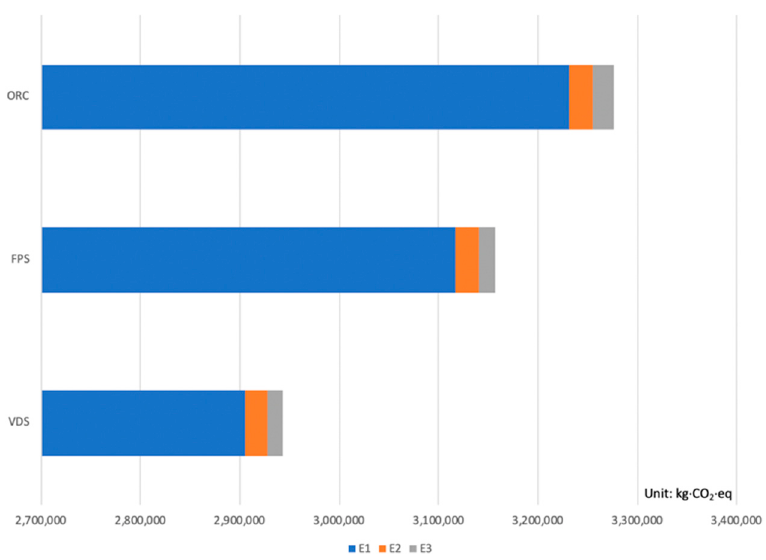
Figure 4. Total carbon dioxide emissions (unit: kg CO 2